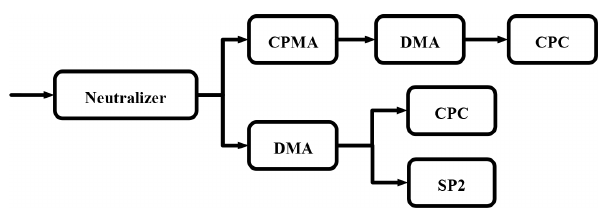
Figure 2. Schematic of the instrument setup.